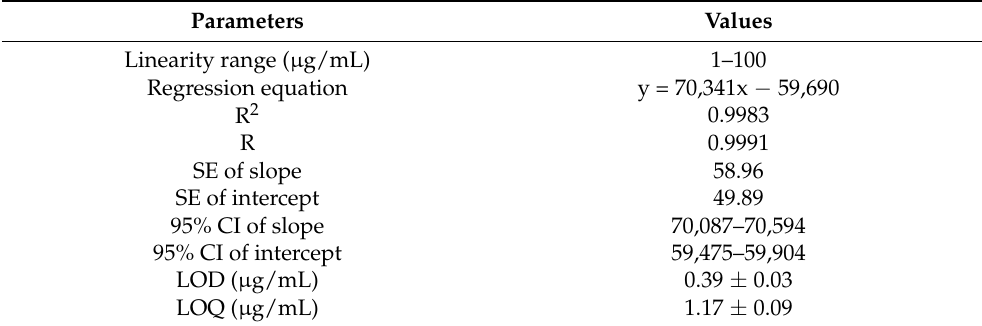
Table 2. Linear regression data for the calibration curve of CCM for the greener high-performance liquid chromatography (HPLC) methodology (mean ± SD, n =